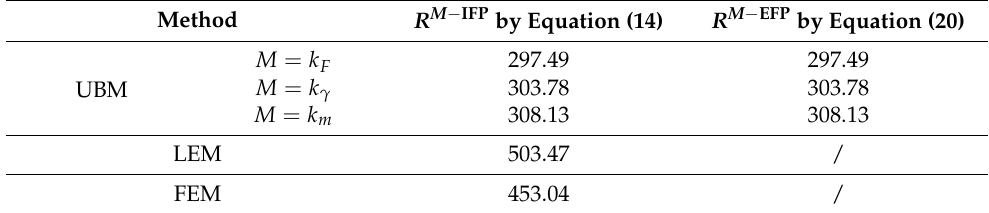
Table 4. Statistics of homogeneous slope failure risk.